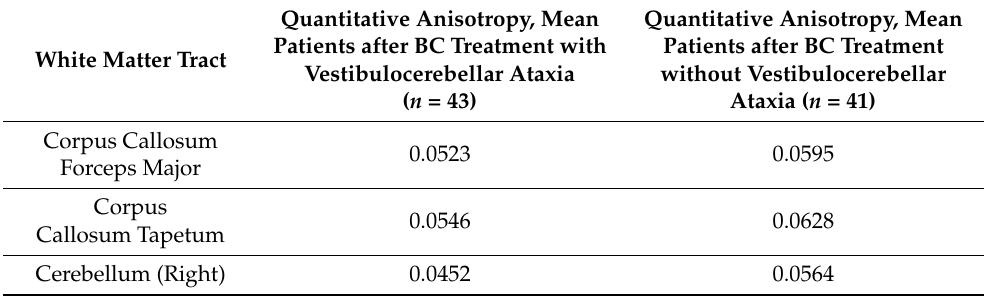
Table 6. White matter tracts with lower quantitative anisotropy in patients after BC treatment with the presence of vestibulocerebellar ataxia in comparison with patients after BC treatment without vestibulocerebellar ataxia.